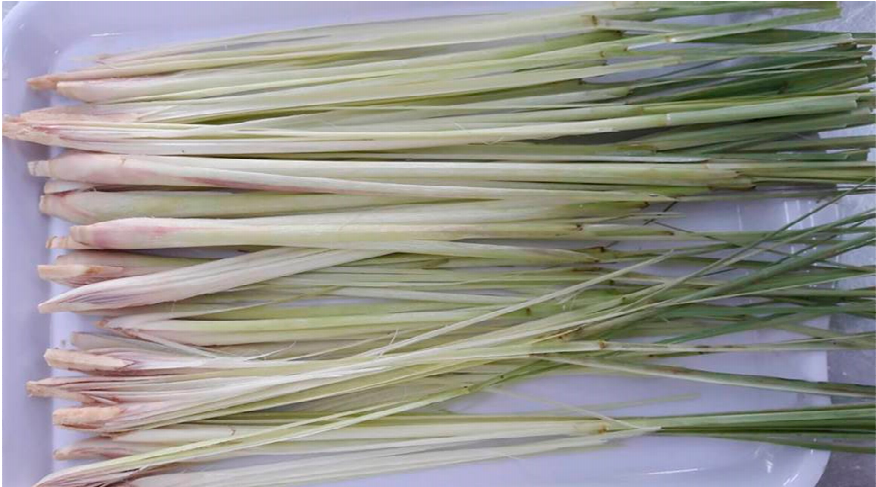
Figure 1. The lemongrass material.